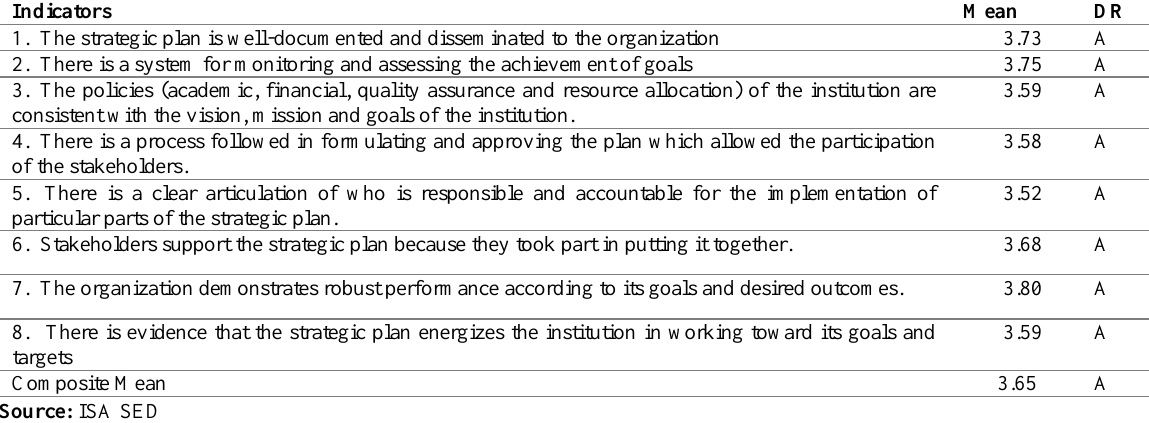
Table 2: Corporate Governance in terms of Strategic